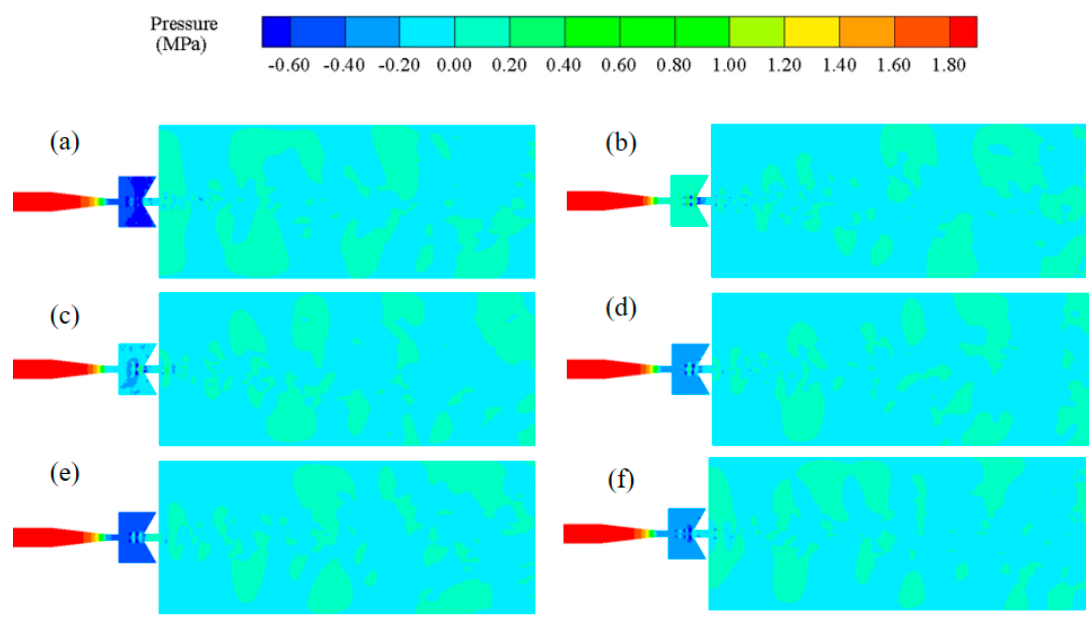
Figure 7. Static pressure variation of SEOPJ at different time ( Δ t = 5 ms). ( a ) t = t 0 + Δ t ; ( b ) t = t 0 + 2 Δ t ; ( c ) t = t 0 + 3 ∆ t ; ( d ) t = t 0 + 4 ∆ t ; ( e ) t = t 0 + 5 ∆ t ; ( f ) t = t 0 + 6 ∆ t .